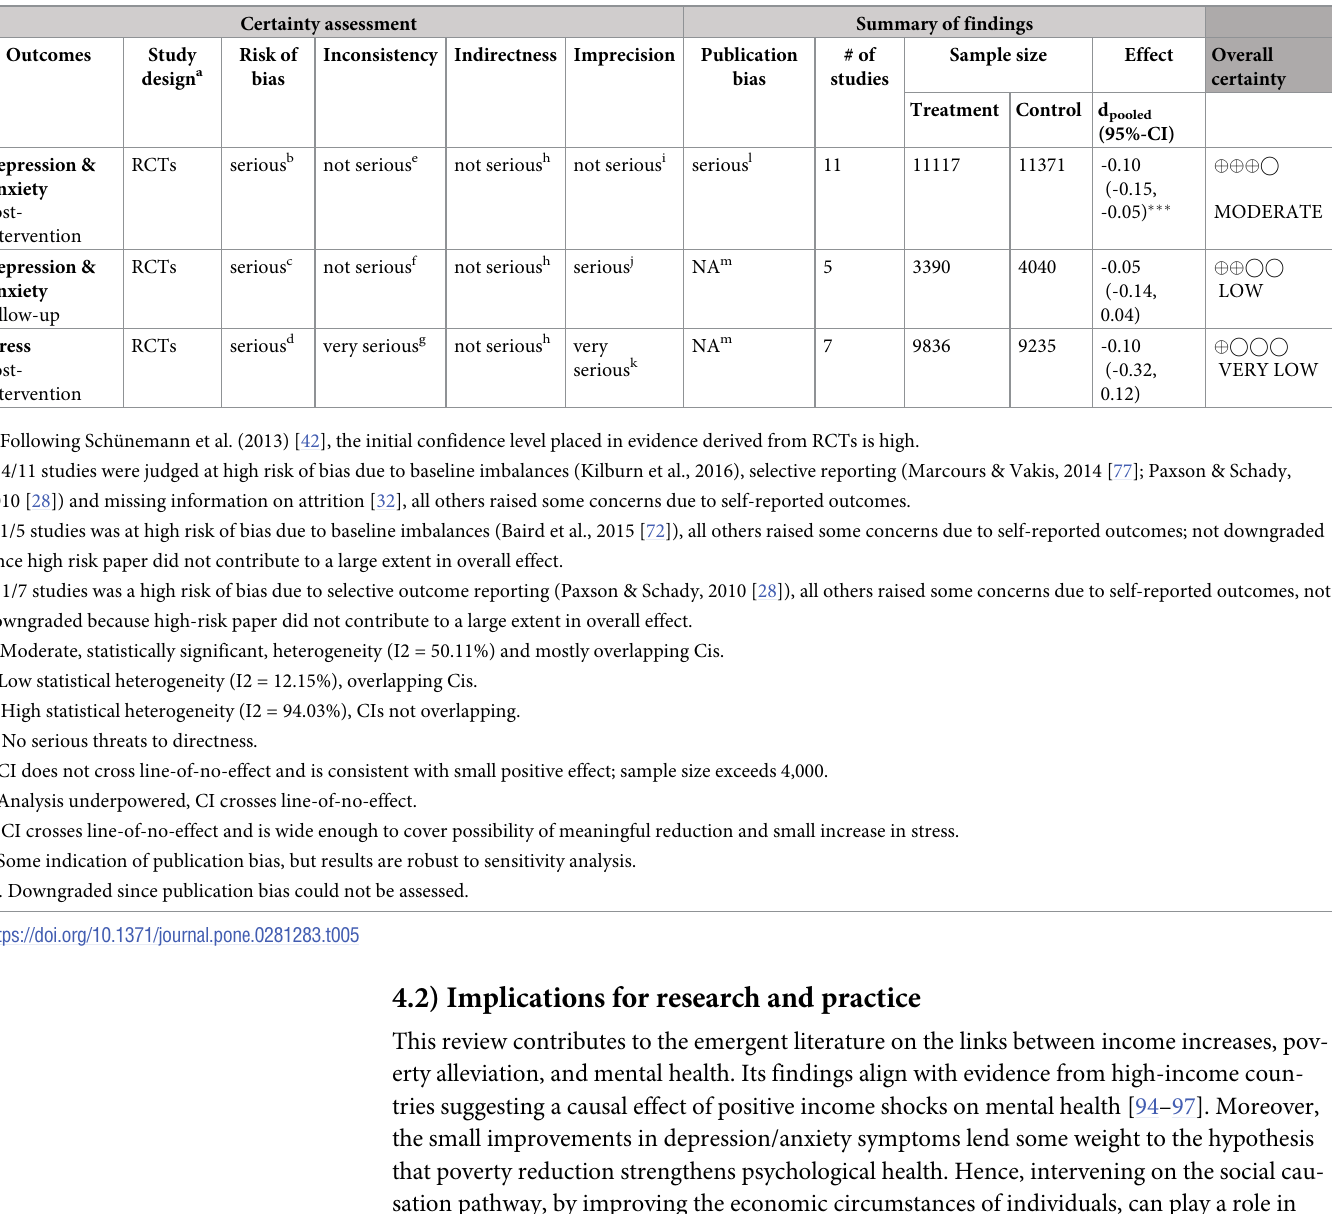
Table 5. Summary of findings table &